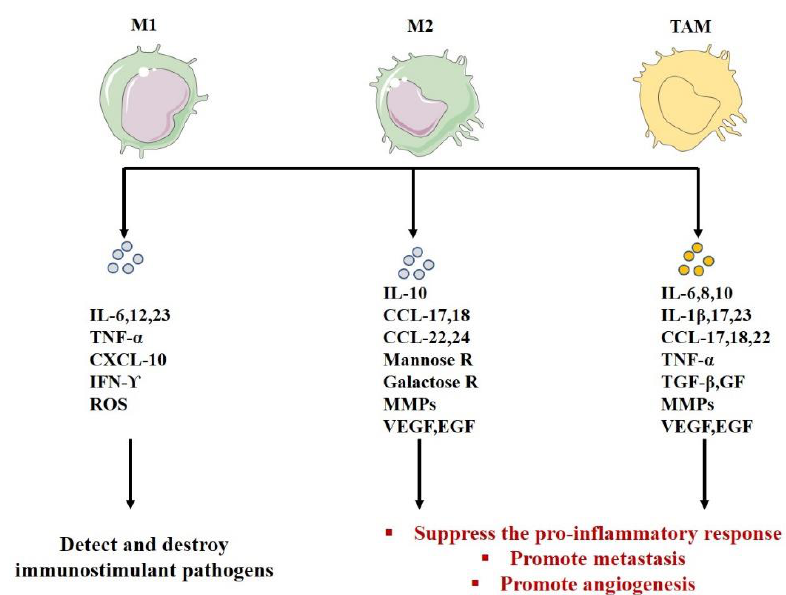
Figure 3. The functions of macrophages M1, M2, and TAMs according to their secretion.